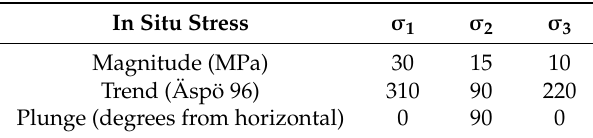
Table 2. Back-calculated stress state for the APSE site [20].